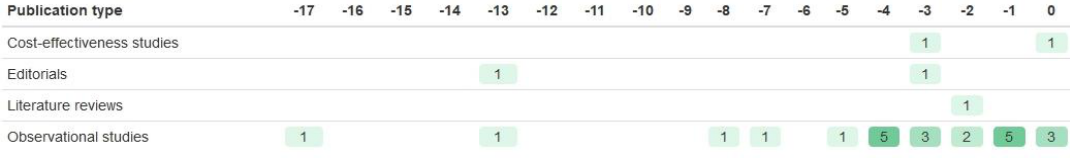
Figure 3. Evidence cited by the EU-PACT trial to justify inclusion of the CYP2C9 and VKORC1 biomarkers, relative to the publication of the 2009 published protocol [49].